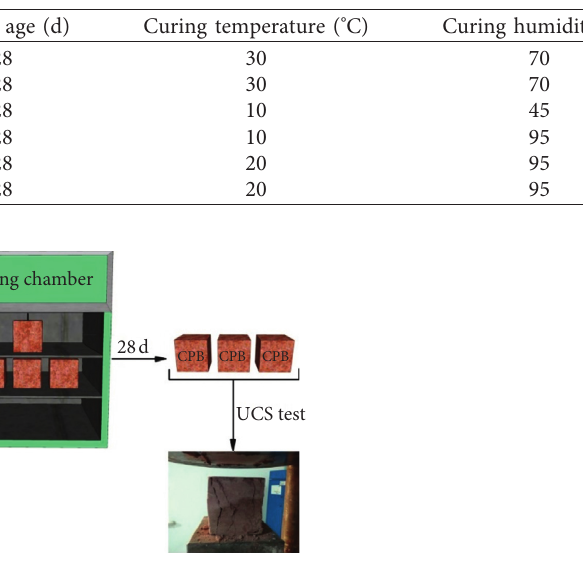
Table 1: Groups of the CPB specimens used for tests.